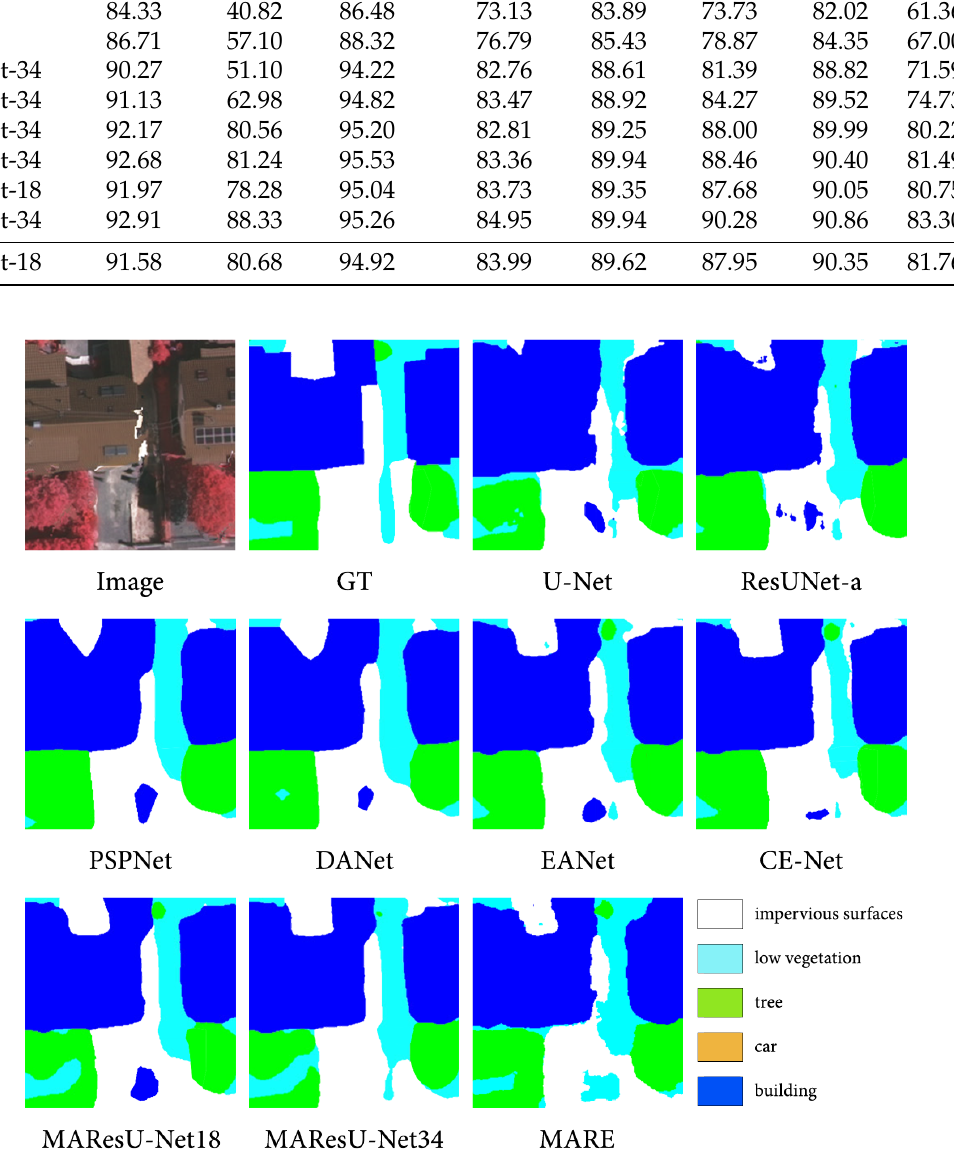
Figure 5. Visualization of the comparison among the different methods on the Vaihingen dataset